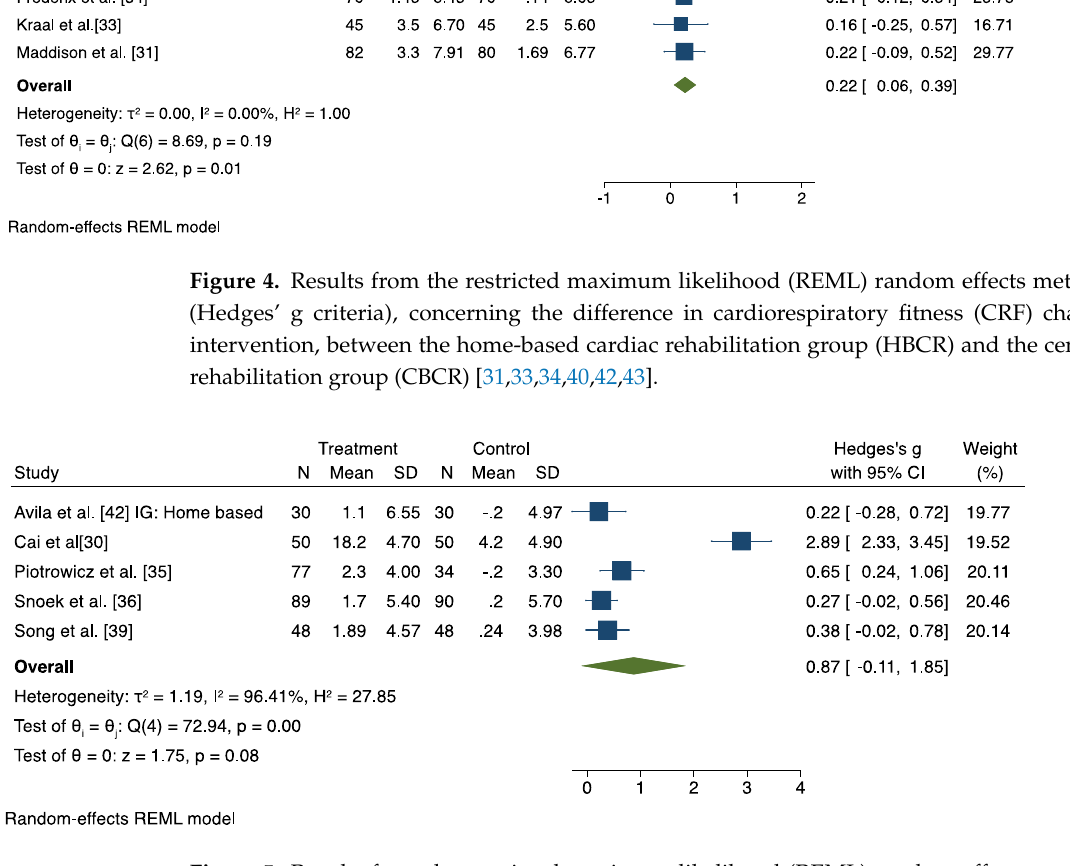
Figure 5. Results from the restricted maximum likelihood (REML) random effects meta-analysis (Hedges’ criteria), concerning the difference in cardiorespiratory fitness (CRF) change post- intervention, between the home-based cardiac rehabilitation group (HBCR) and the usual care group (UC)